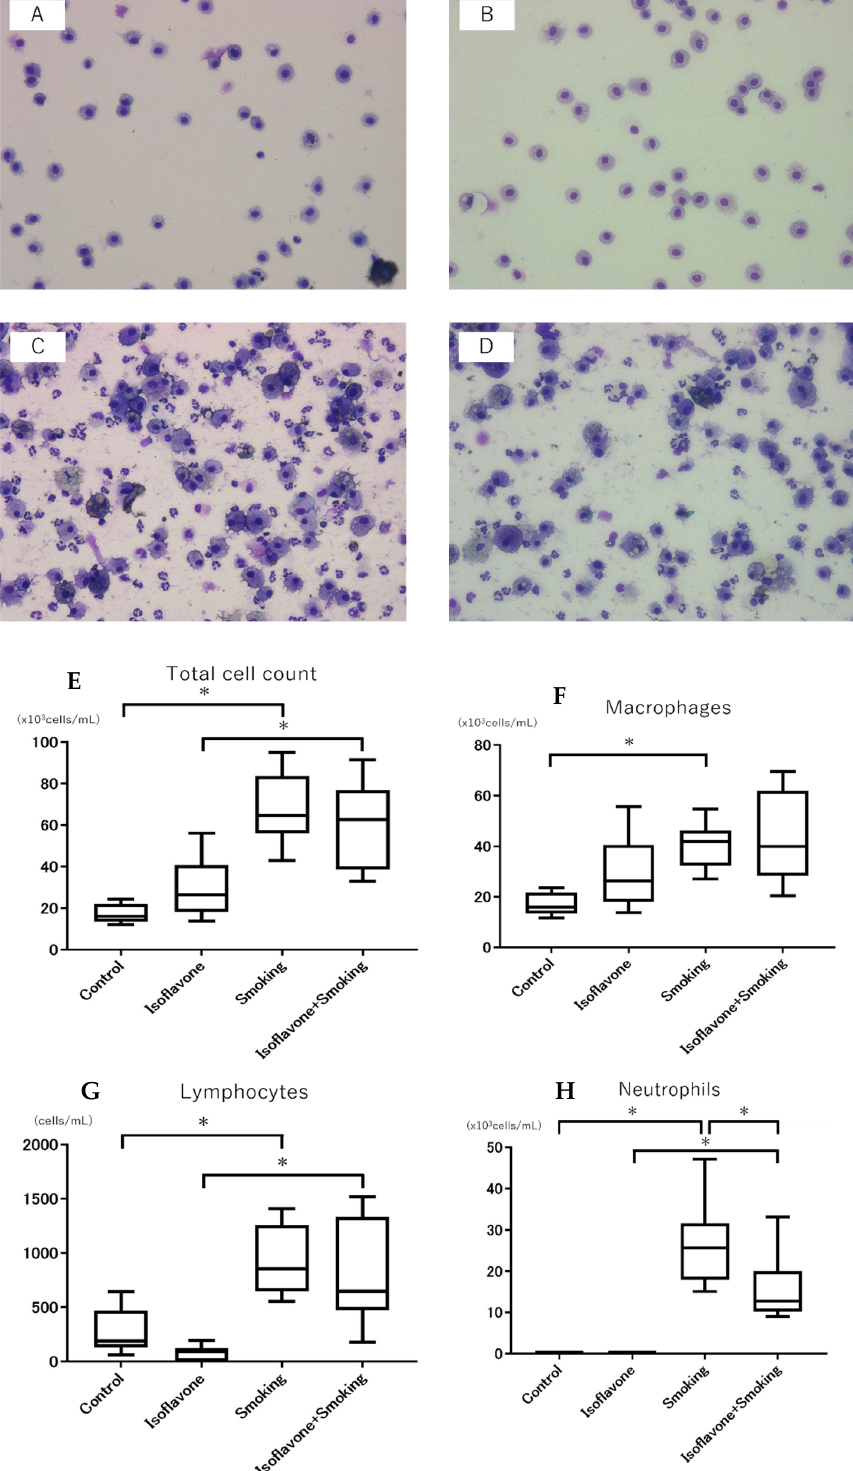
Figure 2. Representative micrographs of the bronchoalveolar lavage fluid (BALF) stained with the Diff-Quick. Images of ( A ) control group, ( B ) isoflavone group, ( C ) smoking group, and ( D ) isoflavone + smoking group are shown at 200 × magnification. The cell counts of ( E ) total cells, ( F ) macrophages, ( G ) lymphocytes, and ( H ) neutrophils in the BALF are shown. Cigarette smoke significantly increased the number of total cells, macrophages, neutrophils, and lymphocytes. Isoflavone aglycones significantly decreased neutrophil cell counts. Data are shown with box and whisker plots. * p < 0.05.